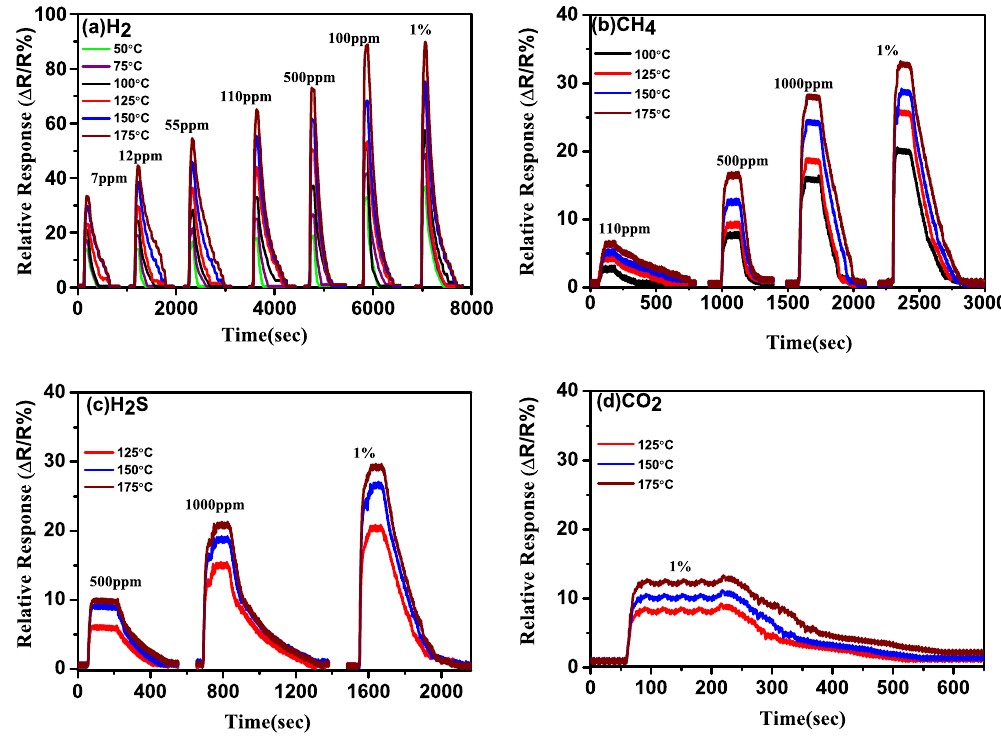
Figure 2. Sensor’s relative response curve with time for 7 ppm to 10,000 ppm of gases: ( a ) H 2 , ( b ) CH 4 , ( c ) H 2 S and ( d ) CO 2 , at operating temperature ranging from 50 °C to 175